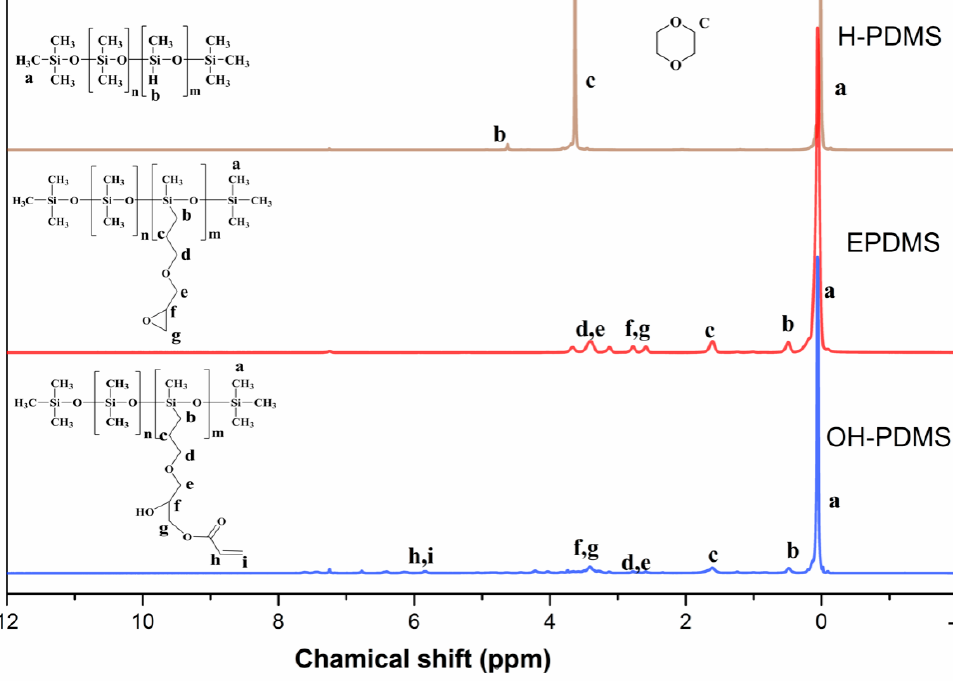
Figure 3. Proton nuclear magnetic resonance ( 1 H-NMR) spectra of H-PDMS, OH-PDMS, and EPDMS.